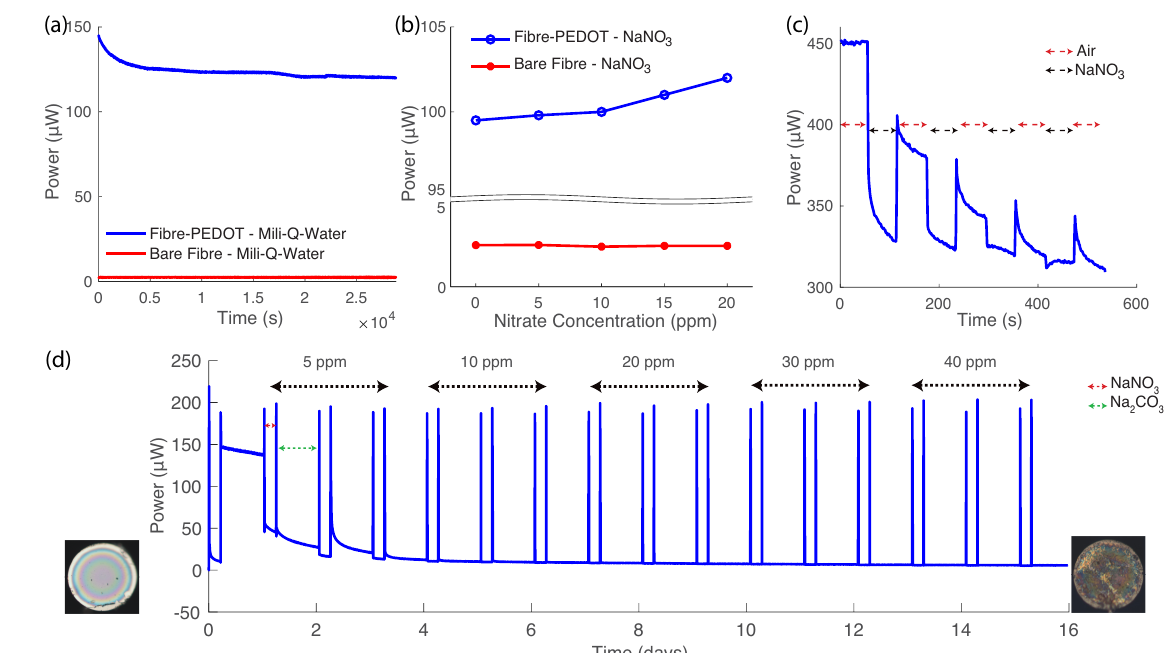
Figure 3. Properties of PEDOT before and after exposure to NO − . ( a ) PEDOT back reflection by reduction in Milli-Q water (blue) and 3 back reflection of fibre (red), ( b ) response of both fibres after addition of droplets of NO − into Milli-Q water, ( c ) a PEDOT sample 3 exposed repeatedly to cycles of NO − solution (50 ppm) and air and ( d ) reusability testing: repeated cycles of NaNO 3 and Na 2 CO 3 3 with 2 min of air in between. The image on the left is the cross section image of PEDOT at the tip of the fibre in reflection mode before the experiment and the one on the right is after all the exposure to NO − and CO 2 − for 21 3 3